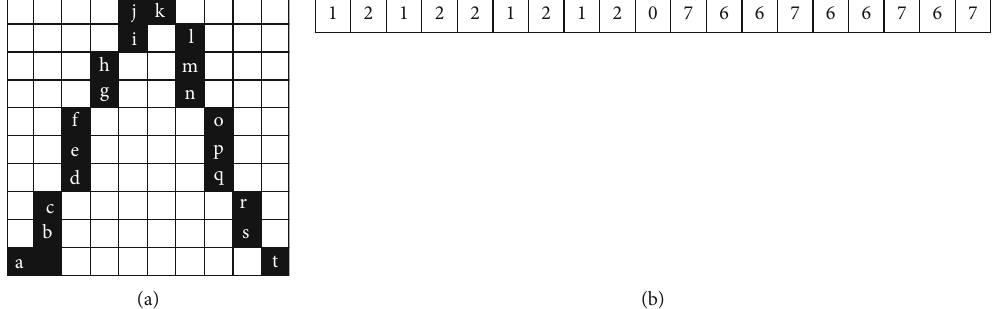
Figure 4: Glyph representation. (a) A glyph component with pixels labeled a , b , c , ⋯ t . (b) The chain code representation of the